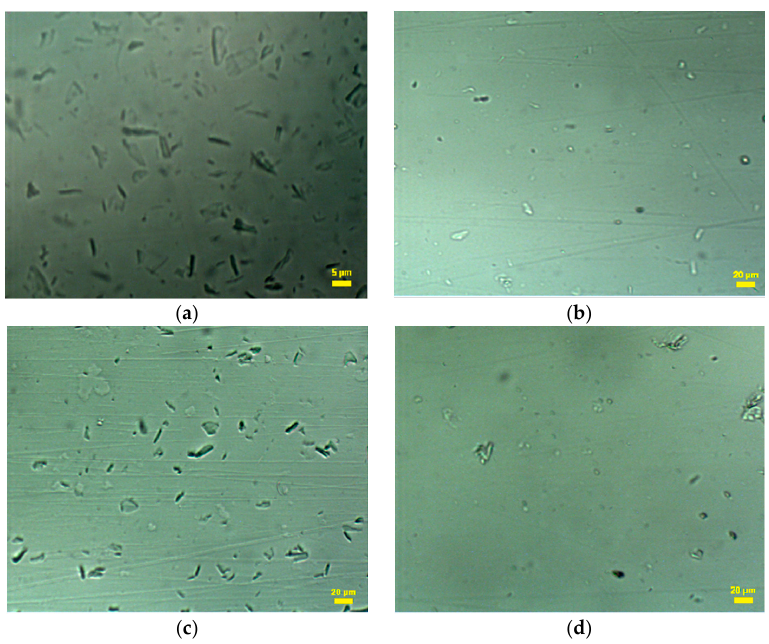
Figure 4. Confocal microscopy of the dispersion of ( a ) CNCs; ( b ) CNC- g -PNIPAM1; ( c ) CNC- g -PNIPAM2; ( d ) CNC- g - PNIPAM3.